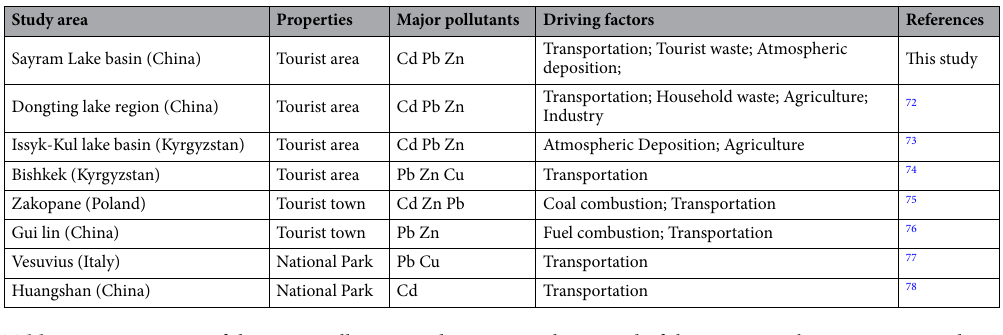
Table 1. Comparison of the main pollutants and sources in the topsoil of the Sayram Lake tourist area and other tourist research areas.